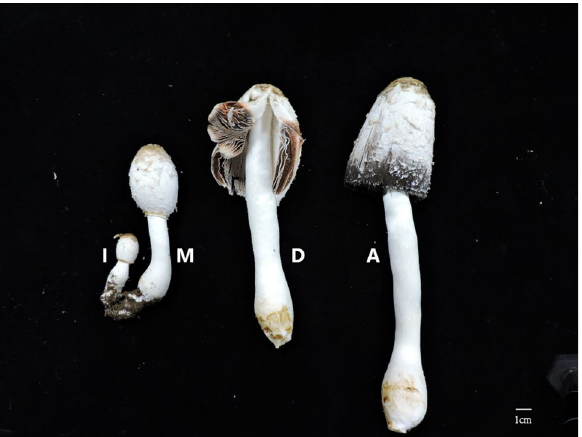
Figure 10. Photographs of the C. comatus fruiting body at four stages of development. ( A ) Infant stage; ( B ) mature stage; ( C ) discolored stage; and ( D ) autolysis stage. Scale bars 1